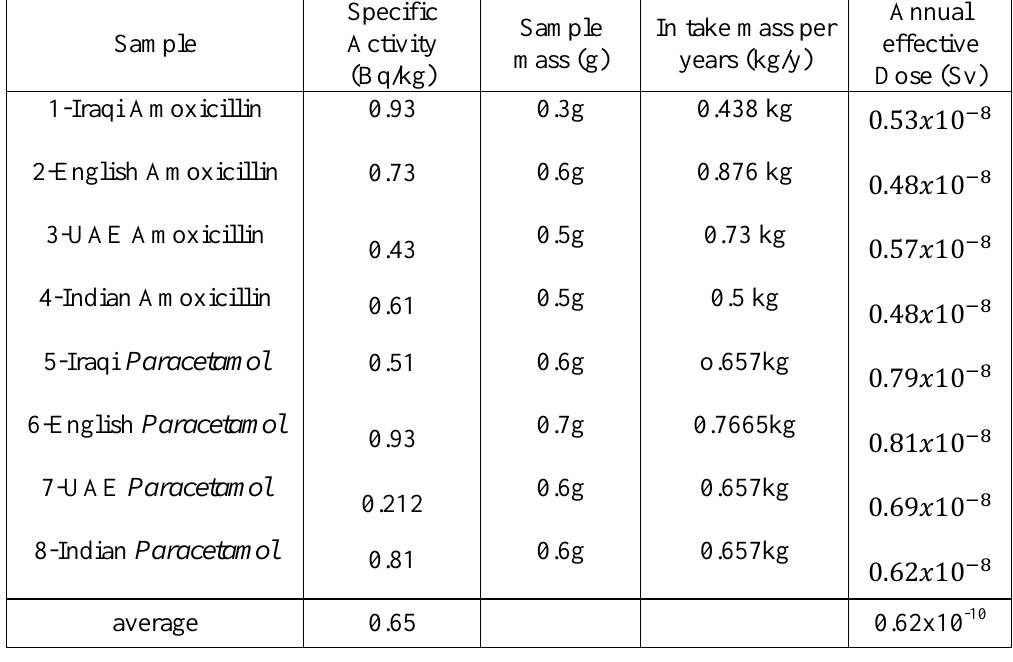
Table 5: Specific activity, sample mass, intake mass per year and annual effective dose of 137 Cs for all samples.